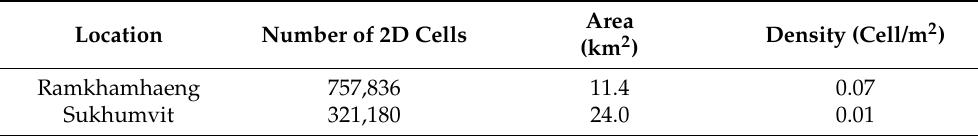
Table 1. The 2D cell density in a unit area in the present model (Ramkhamhaeng polder) and the previous model (Sukhumvit